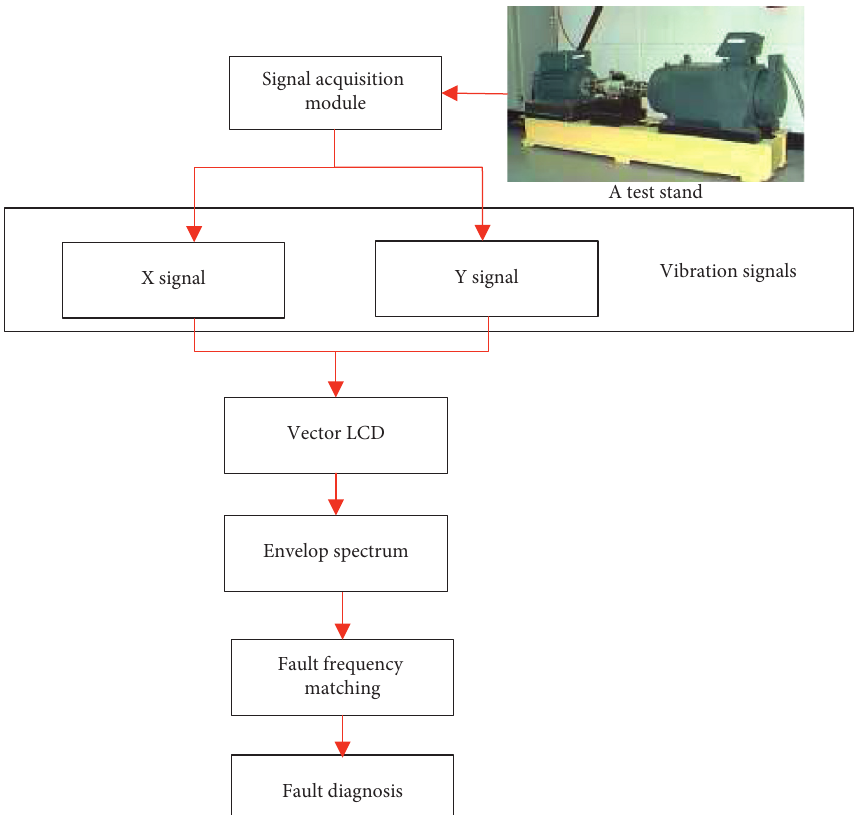
Figure 1: Block diagram of the proposed fault diagnosis method using vector